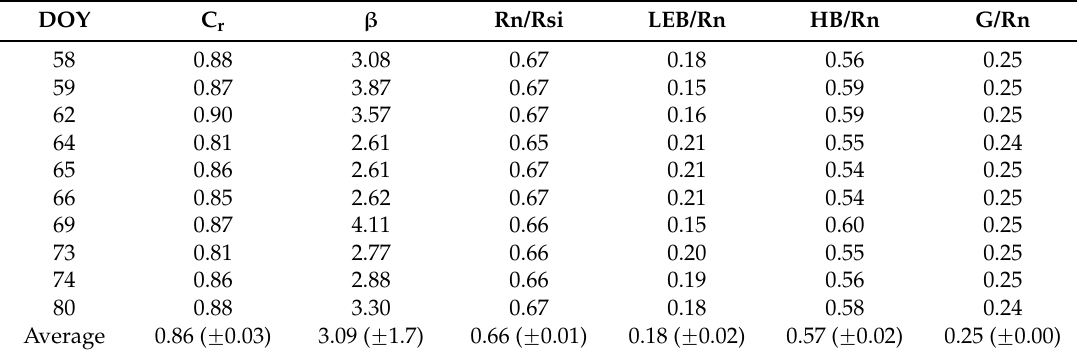
Table 2. Energy balance closure (Cr), Bowen ratio ( β ) and instantaneous ratios of latent (LEB), sensible (HB) and soil (G) heat fluxes to net radiation (Rn) over a drip-irrigated olive orchard at the time of UAV overpasses. Instantaneous ratios of Rn to incoming solar radiation (Rsi) are included.